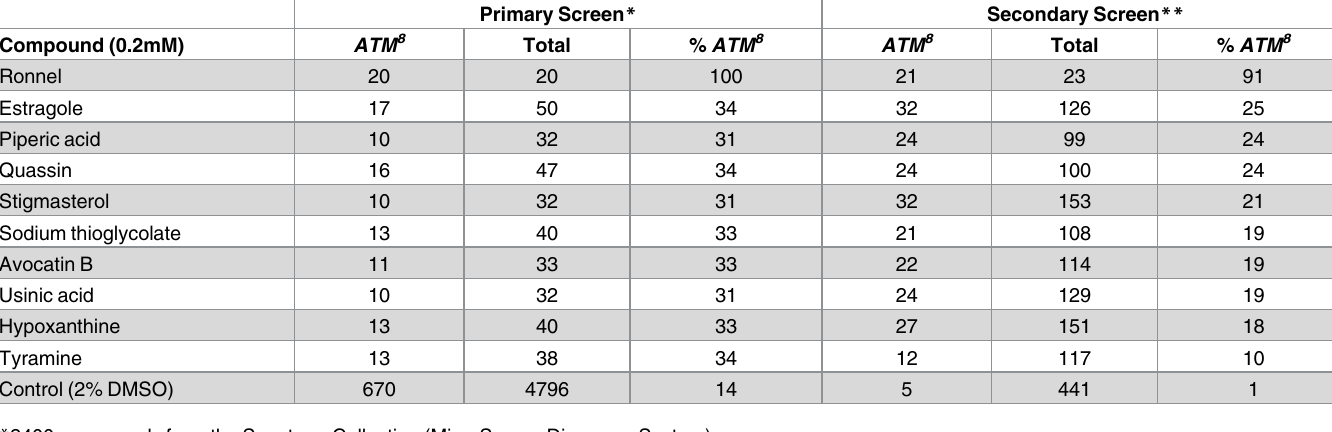
Table 3. Top 10 compounds that reproducibly rescue ATM 8 developmental